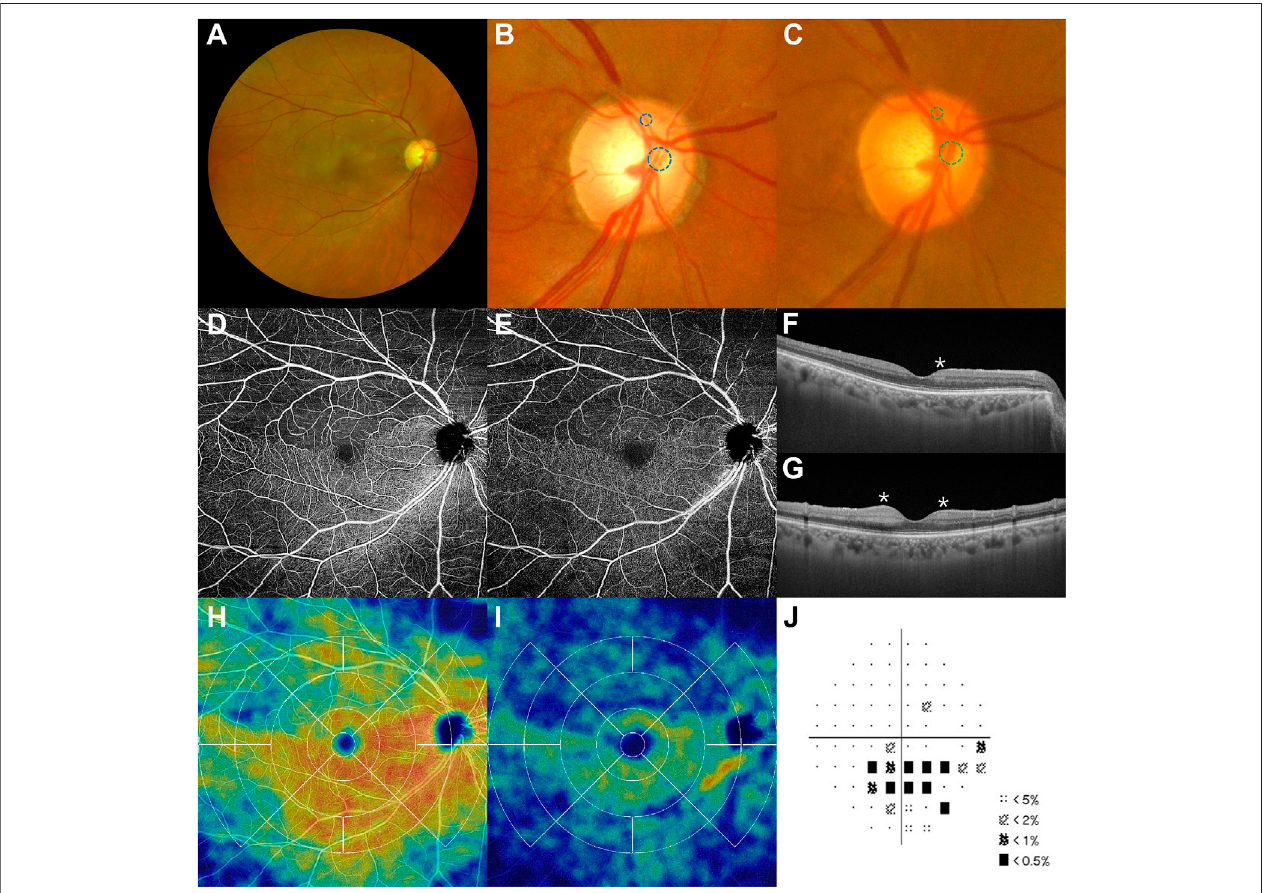
FIGURE 1 | Branch retinal artery occlusion after the fi rst dose of the SARS-CoV-2 mRNA vaccine. Multimodal imaging fi ndings at initial visit including fundus photographs, optical coherence tomography (OCT, DRI OCT-1 Atlantis; Topcon Corp., Tokyo, Japan), and OCT angiography (Cirrus HD-OCT model 5,000 with AngioPlex ™ ; Carl Zeiss Meditec, Inc., Dublin., CA, United States) on day 7 post-vaccination. (A,B) A right upper section of the macula is pale. Multiple thrombi (blue dashedcircles)arefoundinthesuperiorbranchesoftherightcentralretinalartery. (C) Thesethrombiwereabsentinthearteries(greendashedcircles)6 yearsago. (D,E) SCPandDCPontheupper hemisphere arebarely visiblebecauseofattenuated decorrelationsignals. (F,G) Innerretinal edema(asterisks),acharacteristic fi nding of retinal artery occlusion, exists near the fovea. (H,I) Superior macular perfusion to SCP and DCP decreases rather than the inferior side. (J) Automated Humphrey perimetry reveals an arcuate anopsia to the inferior fi eld. DCP, deep capillary plexus; SCP, super fi cial capillary plexus.